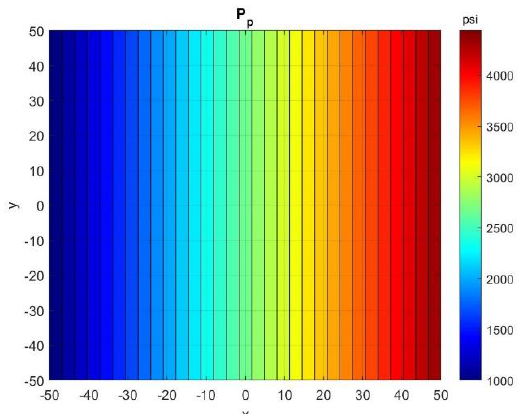
Figure 3. Pore pressure variation in the LSM model along the lateral x -axis, ranging from 1000 to 4439 psi.